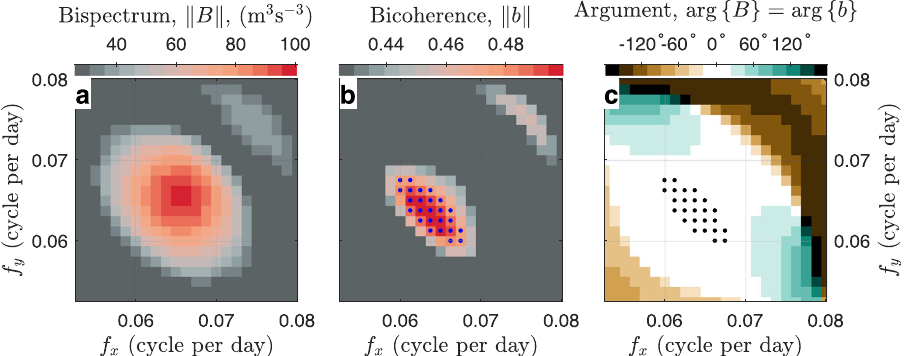
Fig. 3 | Bispectral spectra averaged within 80 – 96 km, between Juliusruh and Mohe,andbetweenzonalandmeridionalwindsobservedbetween1November 2018 and 31 January 2019. a Bispectrum. b Bicoherence. c Bispectral argument